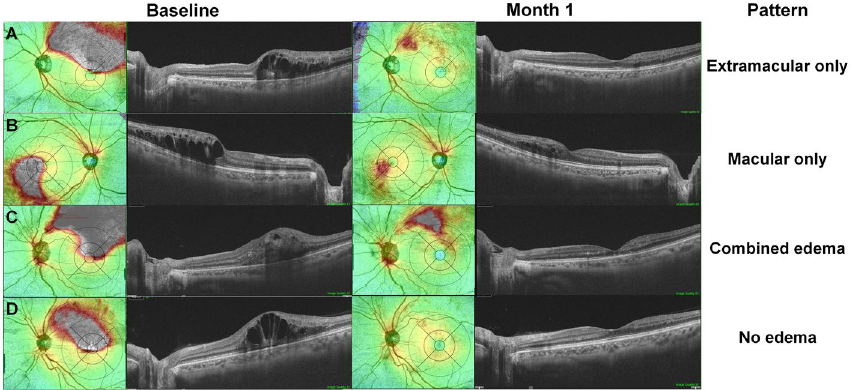
Figure 2. Pattern of retinal edema 1 month following anti-vascular endothelial growth factor (VEGF) therapy for macular edema (ME) due to branch retinal vein occlusion (BRVO). Four patterns, (extramacular only [ A ], macular only [ B ], combined edema [ C ], and no edema [ D ]) are noted from the widefield retinal thickness maps. The areas of residual edema are mostly wedge-shaped and located between the fovea and site of vascular occlusion.